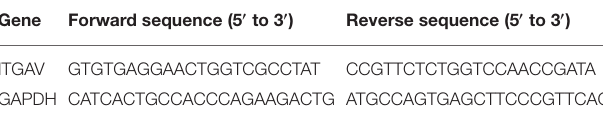
TABLE 2 | List of primer sequence used for